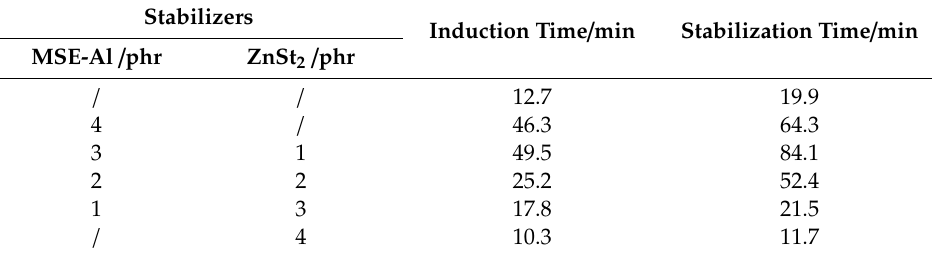
Table 1. Induction time and stabilization time for di ff erent PVC